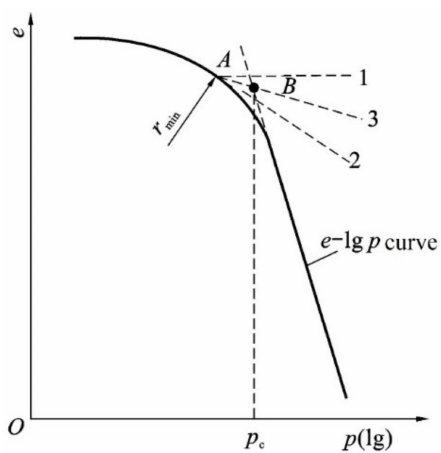
Figure 3. Casagrande empirical graphing